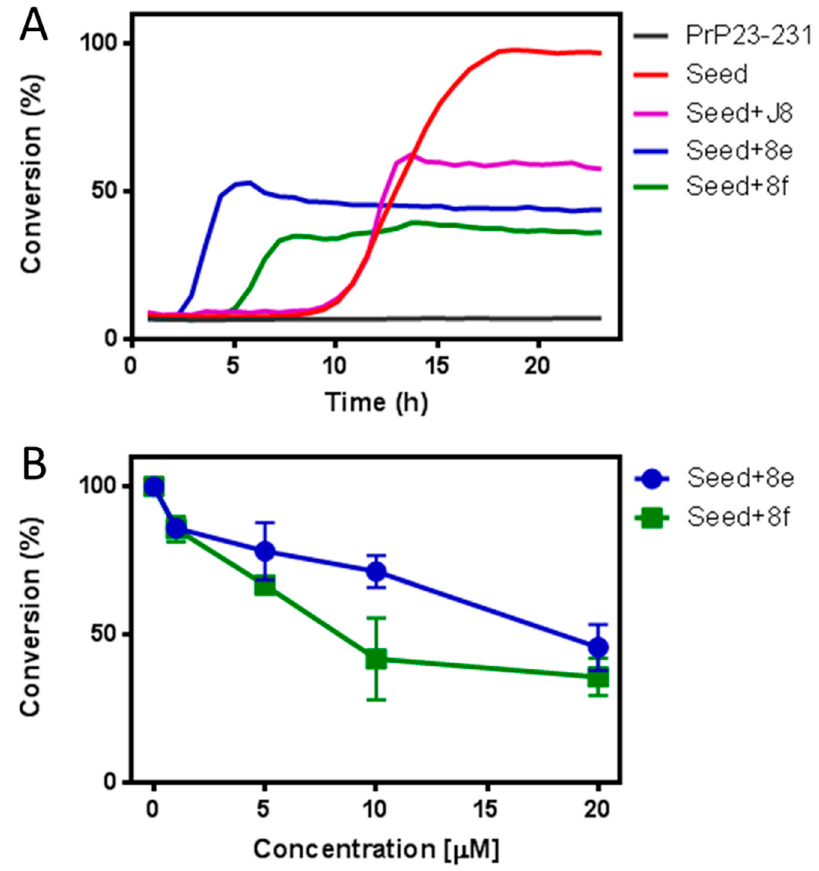
Figure 3. 8e and 8f decrease PrP seeding conversion and aggregation into fibrils. ( A ) RT-QuIC reactions with recombinant PrP23-231 (4 µ M) as substrate in the absence (black line, negative control) or presence of PrP23-231 fibril seed (4%) (red line, positive control). The conversion was normalized to the values for the positive control (100%) and the negative control (0%). All compounds were incubated in the starting reaction at 20 μ M. All conditions were performed in quadruplicate. Representative data of three independent experiments. ( B ) Conversion after RT-QuIC reactions of recombinant PrP23-231 with different compound concentrations. Data are represented as the mean of three independent experiments, and error bars represent the standard deviation.